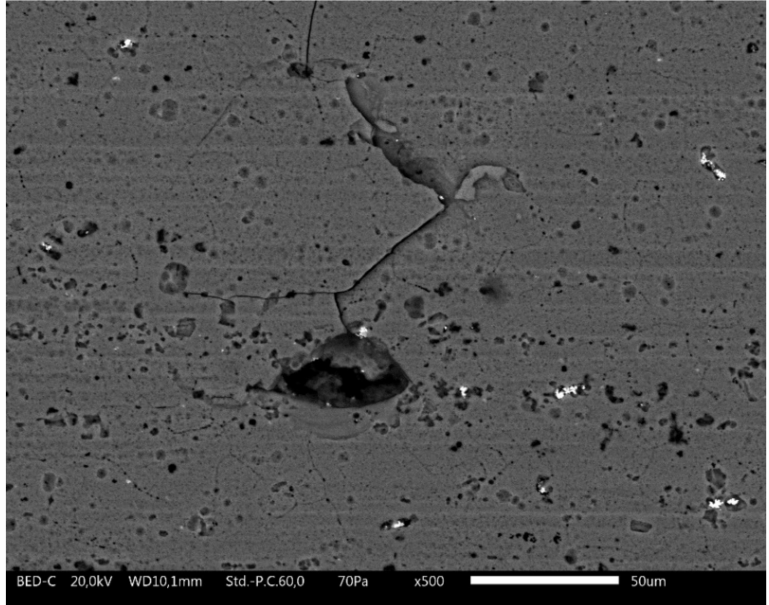
Figure 7. SEM micrographs of the surface of sample A after 24 h of